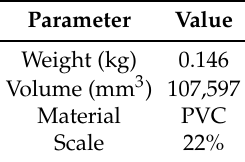
Table 3. Parameters of the model for the free decay pendulum